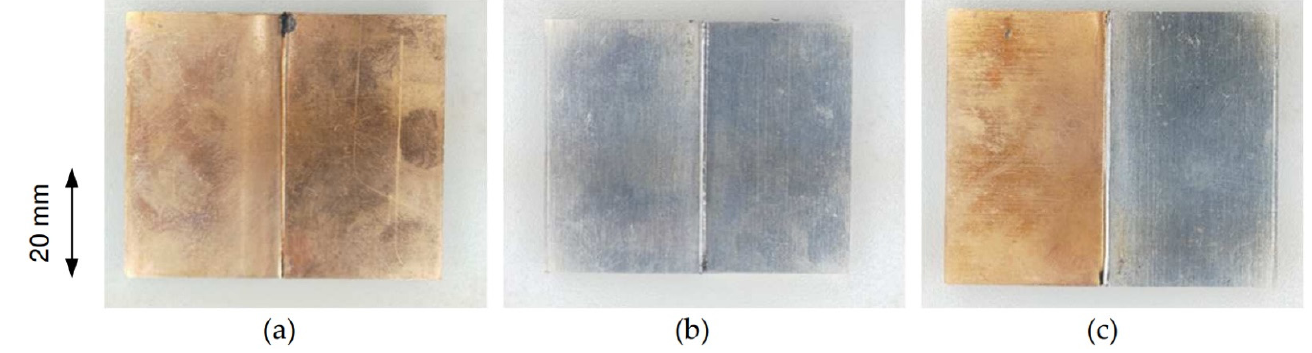
Figure 4. General view of joined specimen: ( a ) C1100-C1100; ( b ) A6061-A6061; ( c ) C1100-A6061.